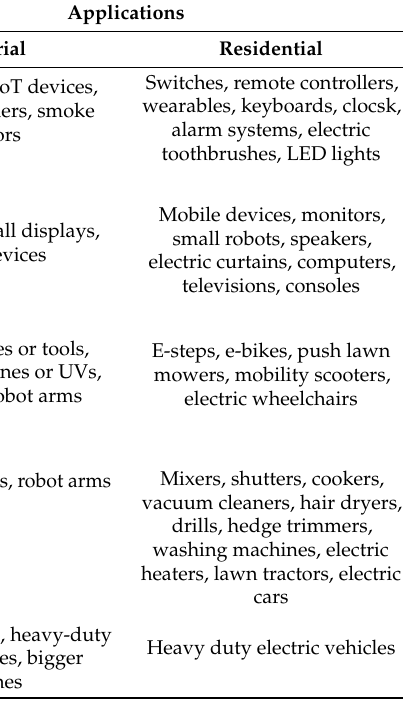
Table 4. Available and emerging standards and technologies for residential and industrial